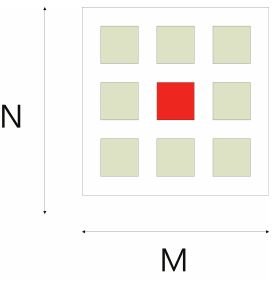
Figure 2. Conventional computing